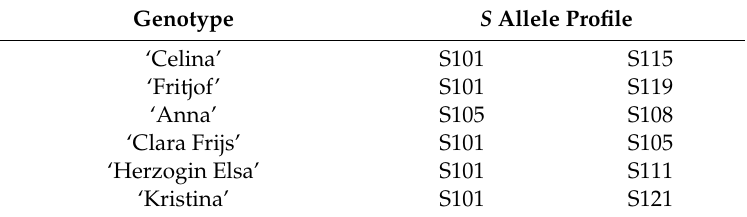
Table 3. The results of S genotyping of the six pear cultivars included in this